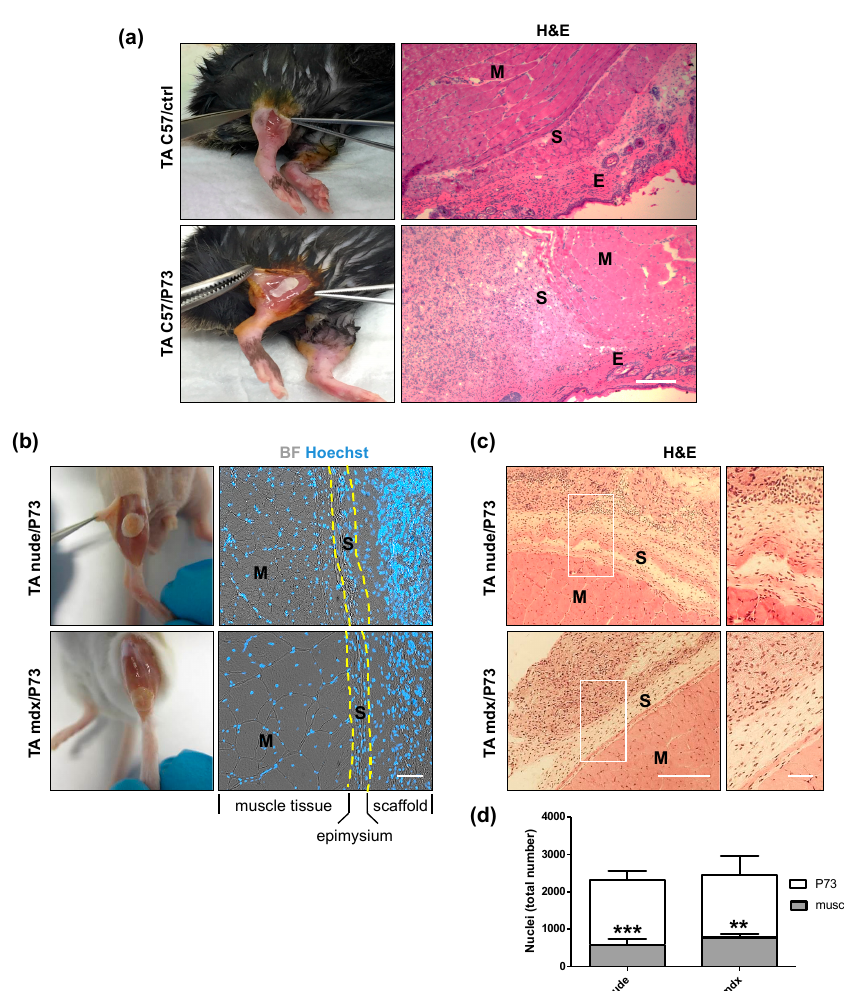
Figure 5. Histological analysis of P73-implanted muscles. ( a ) Exposed tibialis anterior (TA) muscles and H&E staining performed on TA muscles collected from C57BL/6 wt mice without implant (upper panel) and 4 weeks after P73 implantation (lower panel). Micrographs show the presence of the scaffold, indicated with letter S, among the muscle (M) and the epidermis (E). ( b ) Exposed TA muscles showing the micro P73-implanted regions from nude (upper panel) and mdx (lower panel) mice 6 weeks after P73 implantation. In TA muscles from C57BL/6 wt ( a ), nude ( b ) and mdx ( b ) mice, P73 scaffold adheres to the epimysium of host muscle tissues. Dashed yellow lines indicate the borders among muscle, epimysium and scaffold tissues. Blu = nuclei; grey = bright field. ( c ) Scaffolds appeared highly cellularised, if compared with the muscle tissue of implanted area, as shown by H&E staining. Similar amounts of cell-colonised scaffold were found between C57BL/6 wt ( a ), nude ( c ) and mdx ( c ) muscles. Upper right and lower right panels in ( c ) show magnification areas of representative regions of rectangles from nude and mdx muscles, respectively. ( d ) Quantitative analysis of ( c ) (nude mice n = 5, mdx mice n = 3); ** p < 0.01; *** p < 0.001 vs. P73. Scale bars: a = 100 µm b = 50 µm; c = 100 µm; c (magnification) = 50 µm.